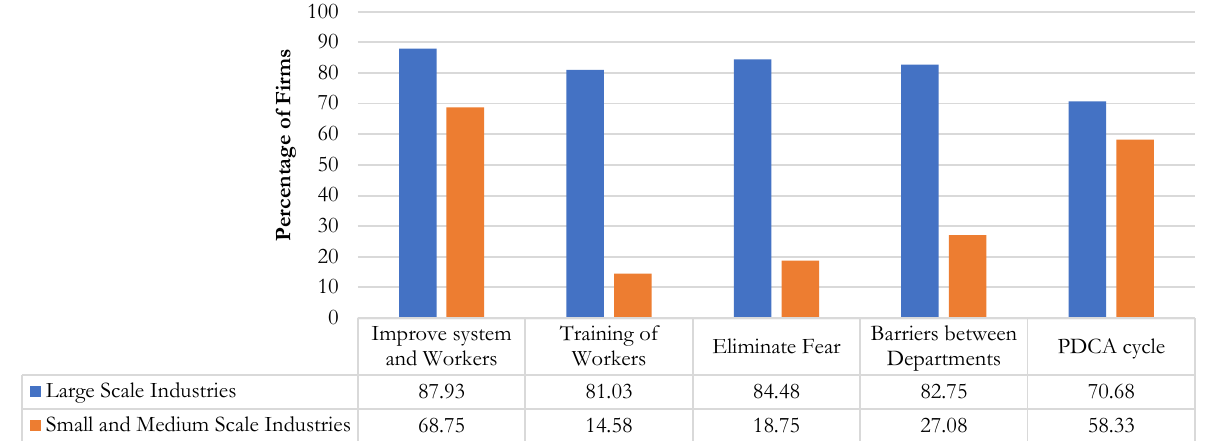
Fig. 3. Comparison of TQM tools between two groups of